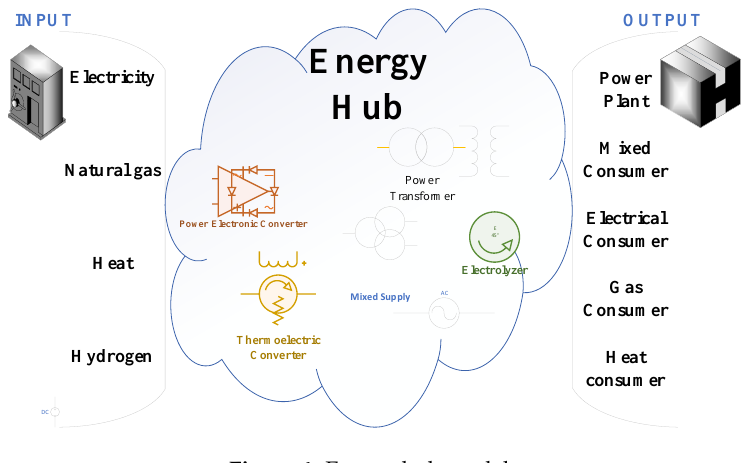
Figure 4. Energy hub model.